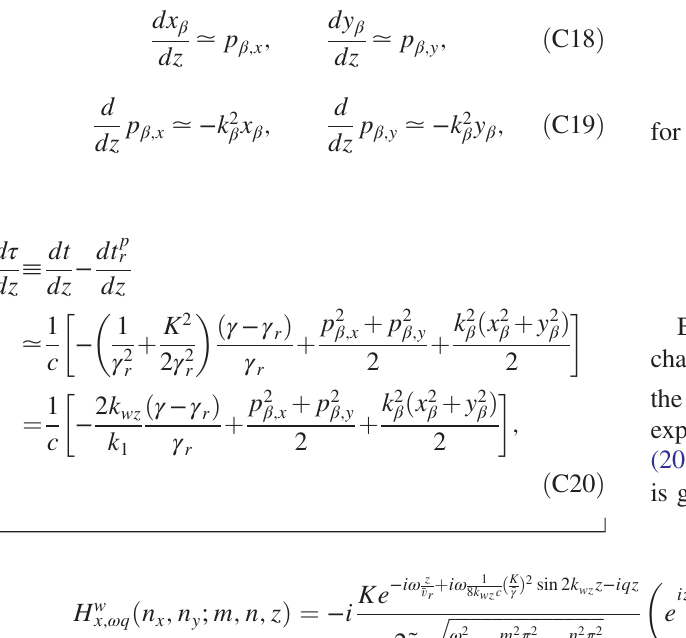
ffiffiffiffiffiffiffiffiffiffiffiffiffiffiffiffiffiffiffiffi